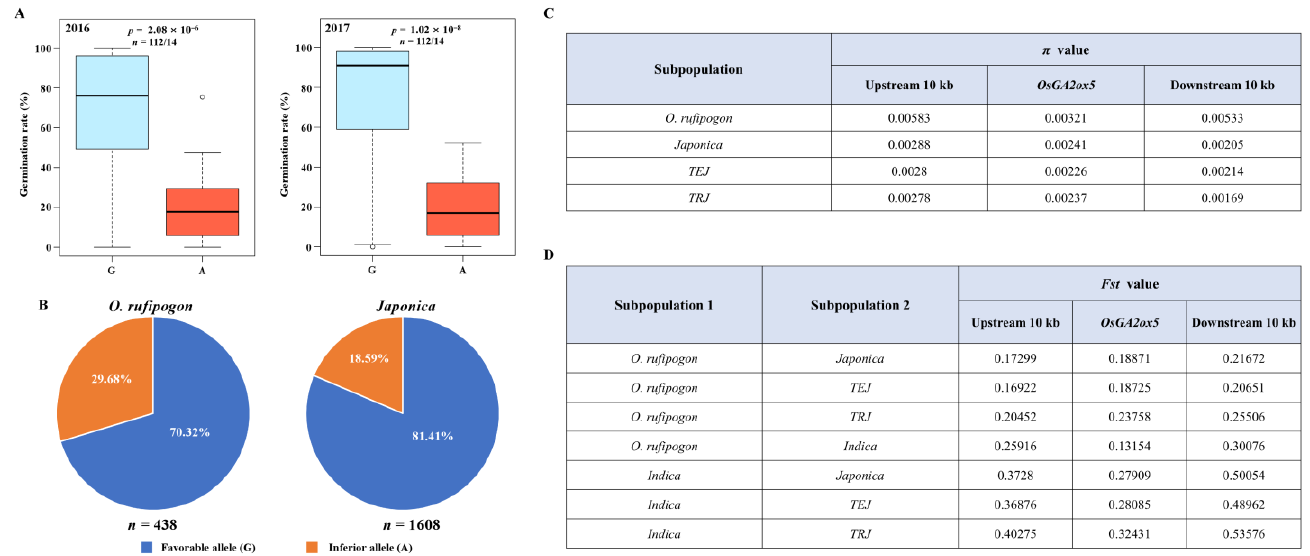
Figure 5. Population genetic analysis of OsGA2ox5 . ( A ) Box plots showing the genotype effects of SNP Chr7-218,245 on germination rate in Japonica rice; ( B ) The allelic frequencies of SNP Chr7-218,245 in diverse wild rice and Japonica rice; ( C ) Nucleotide diversity analysis of OsGA2ox5 and its flanking regions (10 kb); ( D ) Population differentiation analysis of OsGA2ox5 and its flanking regions (10 kb). Statistical differences between the G-type (light blue) and A-type (bright red) were analysed using Student’s t -test.